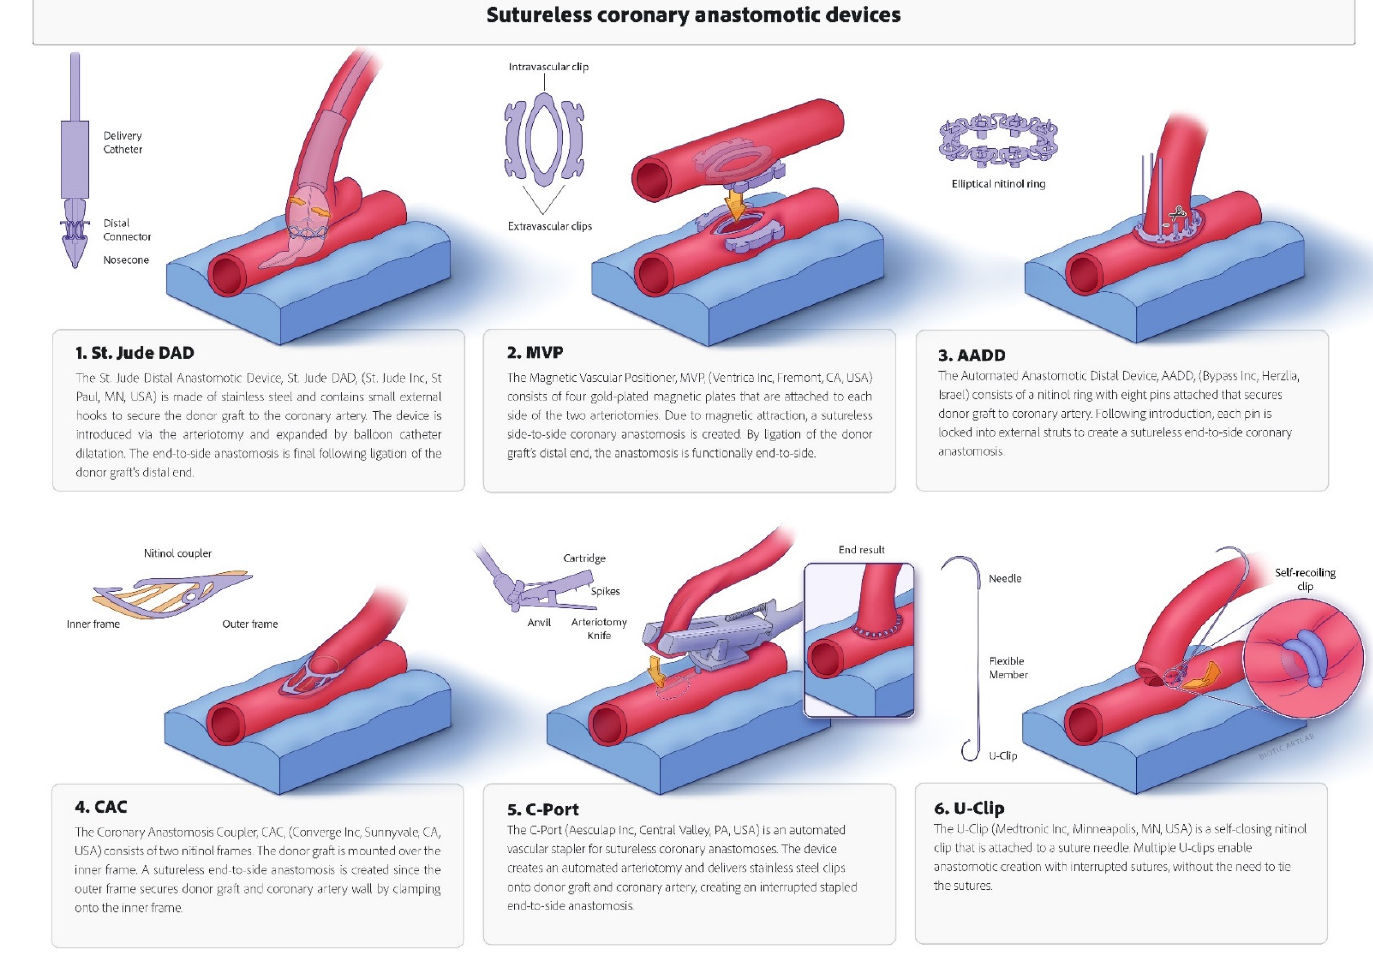
Figure 2. Overview of the sutureless coronary anastomotic devices included in the systematic review.